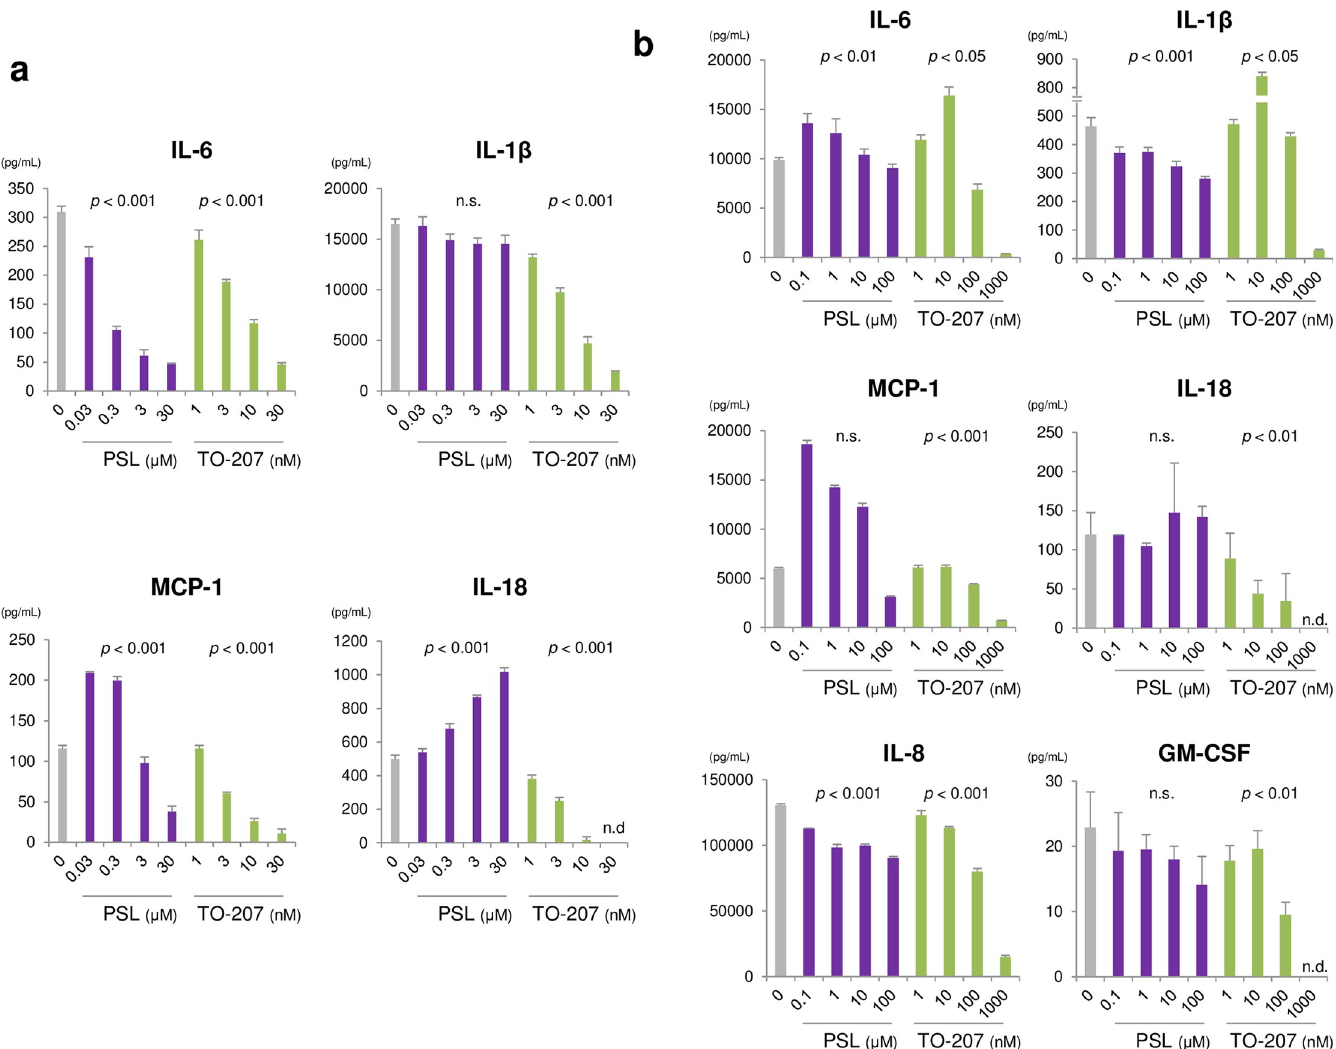
Fig 4. Suppression of monocyte-derived, pro-inflammatory cytokine secretion by TO-207 and IL-6/IL-1 pathway–specific suppression by tocilizumab/anakinra. A) Effects on cytokine production by LPS- and ATP-stimulated monocytes. Peripheral blood mononuclear CD14 + cells (2 × 10 5 ) were seeded in a 96-well plate with culture medium containing PSL or TO-207. The cells were stimulated with 100 ng/mL LPS for 3 h, and then with 5 mM ATP for 2 h. Supernatants were recovered, and cytokine levels were determined. The error bars represent SEs from three independent experiments. B) Wide-ranging suppression of monocyte-derived pro- inflammatory cytokines by TO-207. K562/CD19 cells (3 × 10 3 ), CAR T cells (1.5 × 10 4 ), and CD14 + cells (1.5 × 10 4 ) were co-cultured in a 96-well plate in the absence or presence of PSL or TO-207. After 72 h of co-culture, the supernatants were recovered, and cytokine levels were determined. The error bars represent SEs from three independent experiments. The linear dose-response relationship was assessed using log-transformed dose values (to the base 10) in a mixed model, in which the zero dose was replaced by the log (minimal dose) - 1. P < 0.05 was considered statistically significant. n.s.: not significant. n.d.: not detected.